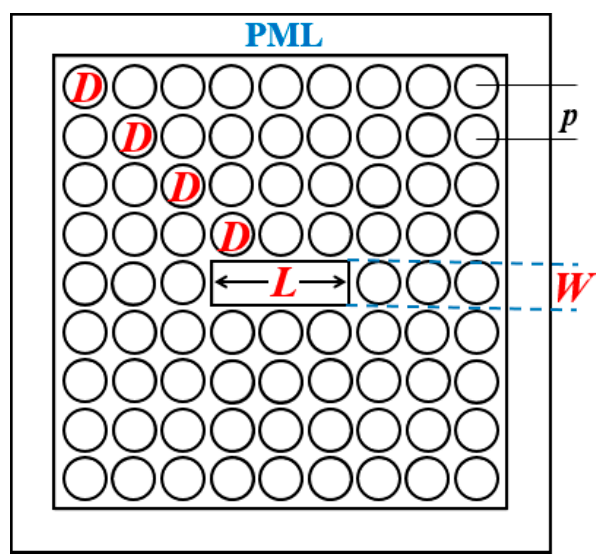
Figure 1. The 2-D cross-sectional view of the proposed hollow core photonic crystal fibers (PCF). Table 1. The refractive index of petrol oil for the presence of di ff erent concentration of kerosene oil [45]. Concentration of 0 100 20 40 60 80 Kerosene (% v / v) (Pure Petrol) (Pure Kerosene) Refractive index 1.418